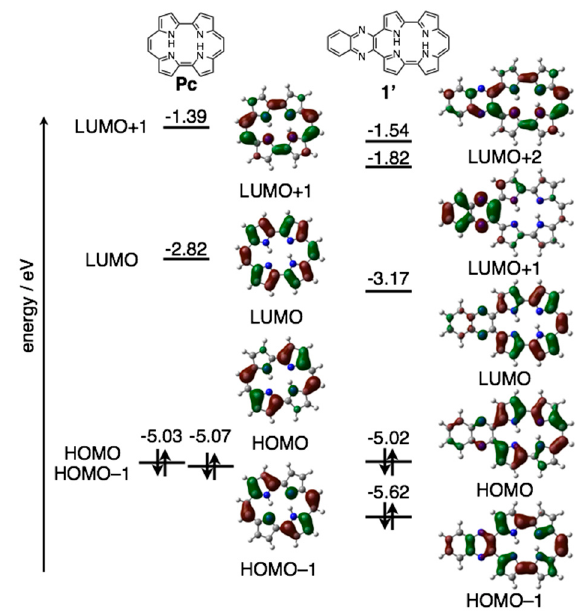
Figure 7. Kohn-Sham molecular orbitals and energy diagrams of Pc and 1’ .